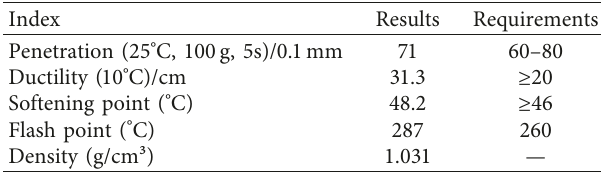
Table 1: Base properties of asphalt